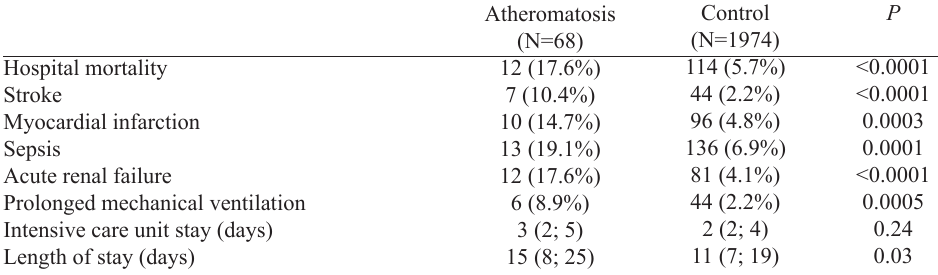
Table 3. Morbidity and mortality data in patients with and without aortic atheromatosis undergoing cardiovascular surgery.